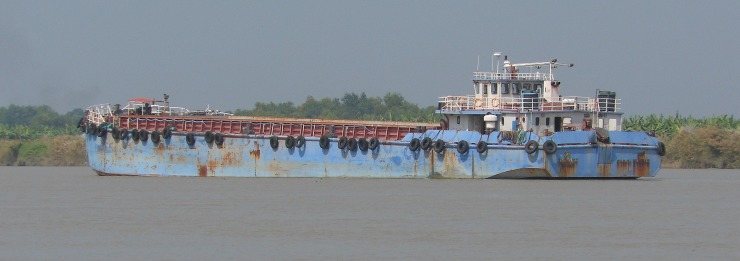
The barge in the National Waterway no. 1.